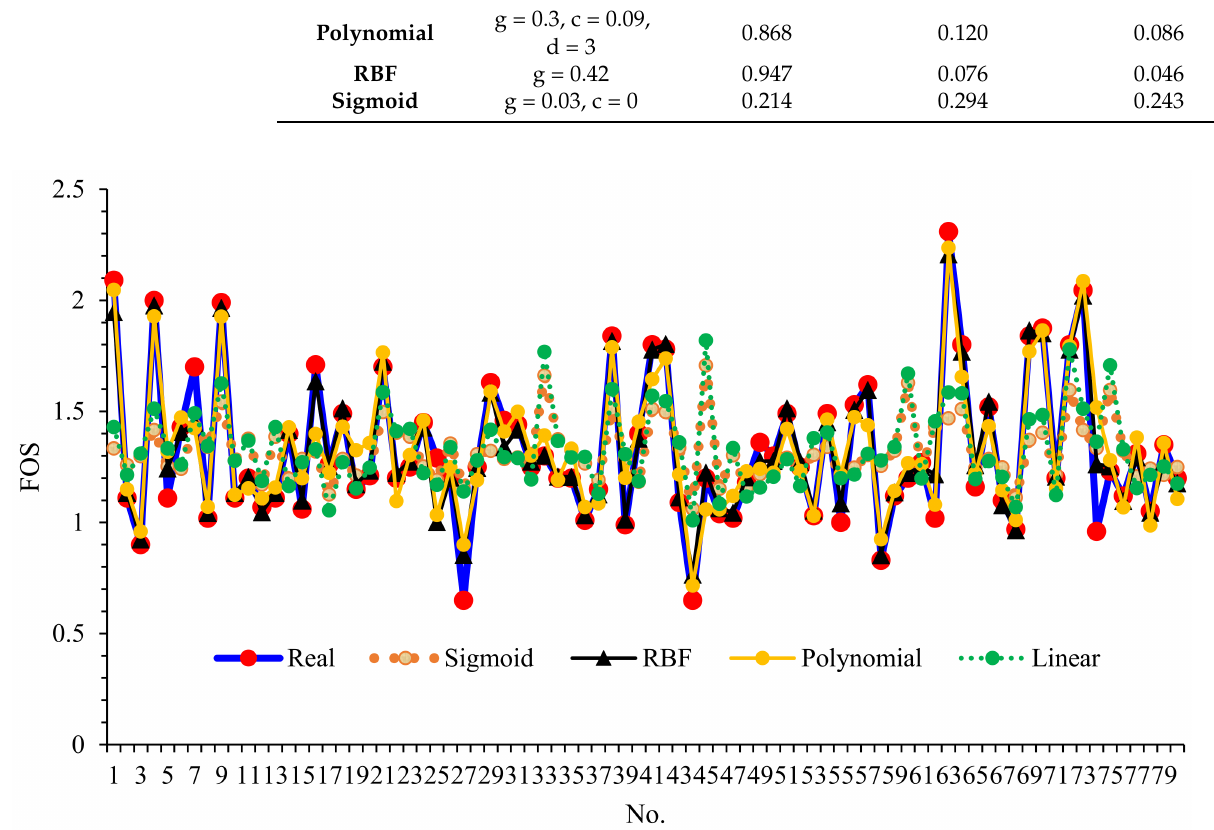
Figure 11. Simulation results for FOS based on various support vector regression (SVR) models.